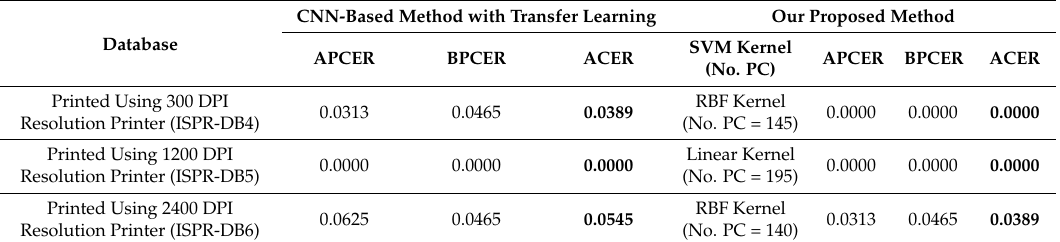
Table 17. Detection errors of our proposed method using VGG-16 network architecture in Table 4 on sub-databases of ISPR-DB based on the printing resolution (unit: